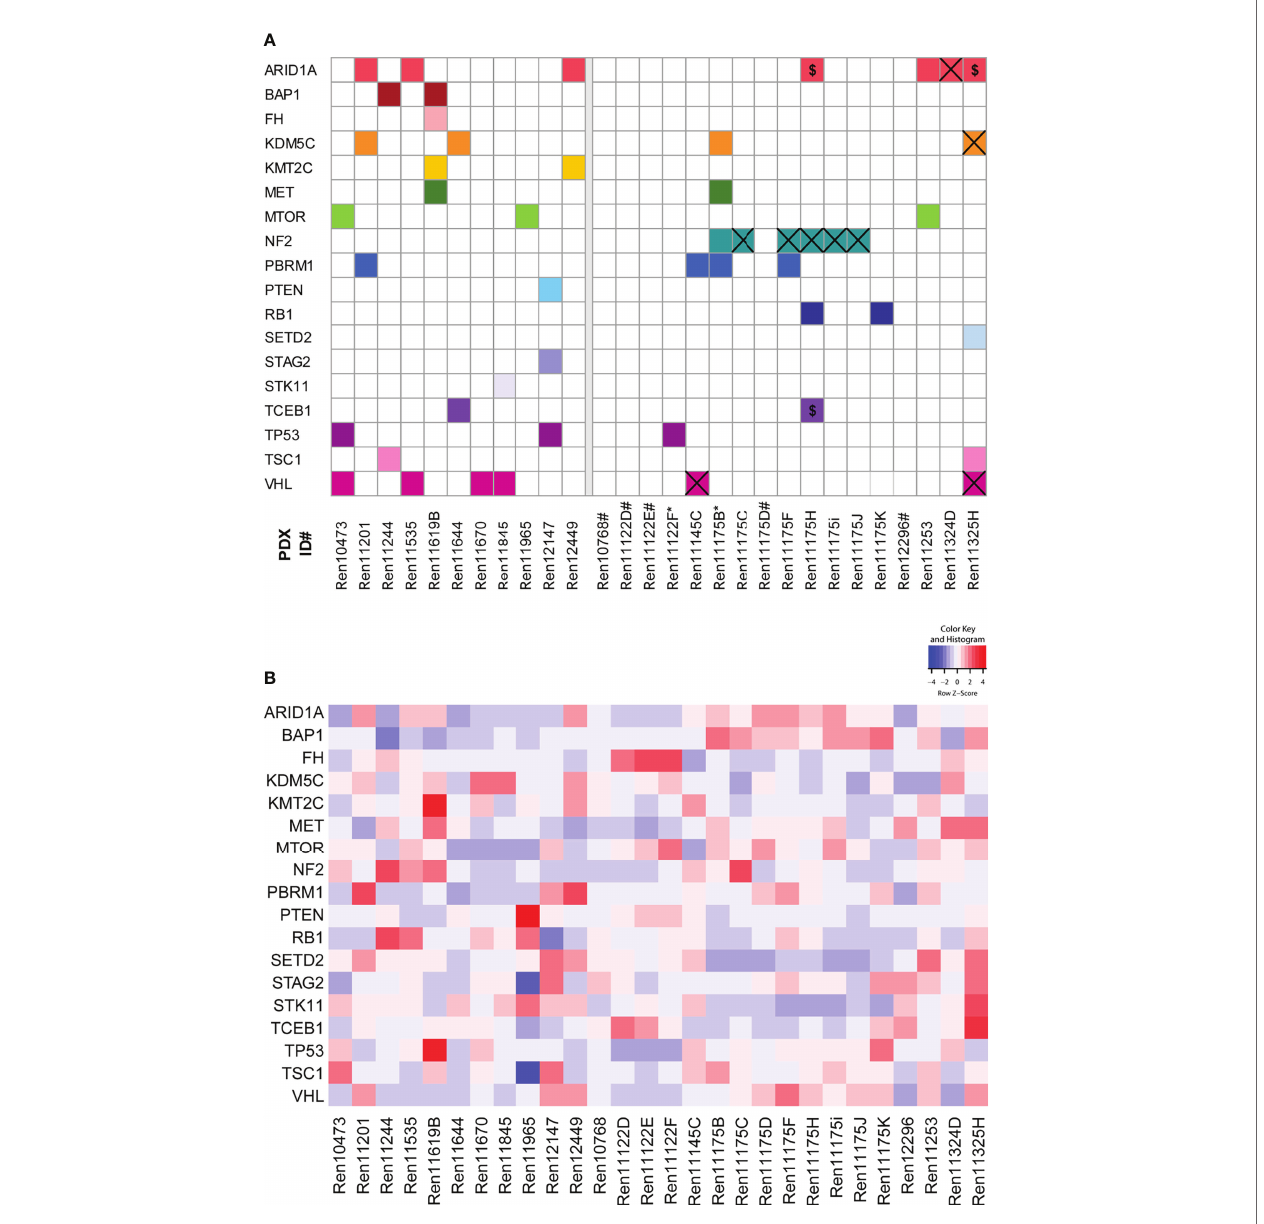
FIGURE 2 | Somatic mutation analysis in RCC PDX models and expression of mutated genes. (A) Using RNA sequencing data, 31 genes that are frequently mutated in RCC were analyzed for somatic mutations. The matrix includes those variants in 18 genes either not included in gnomAD 3.1 or had allele frequencies below 0.0001. The panels separate the models by the tissue source site of their primary tumors and metastases (left: Magdeburg, right: Tübingen). For the Tübingen cases, mutation data from NGS panel sequencing of the primary tumors were also available (except for those marked with *). Overlapping mutations detected in both the primary tumor and the PDX model are highlighted by a cross. $: Variants with low coverage in the primary tumors. #: No somatic mutation found. (B) Gene expression of the 18 mutated candidate genes described in (A)